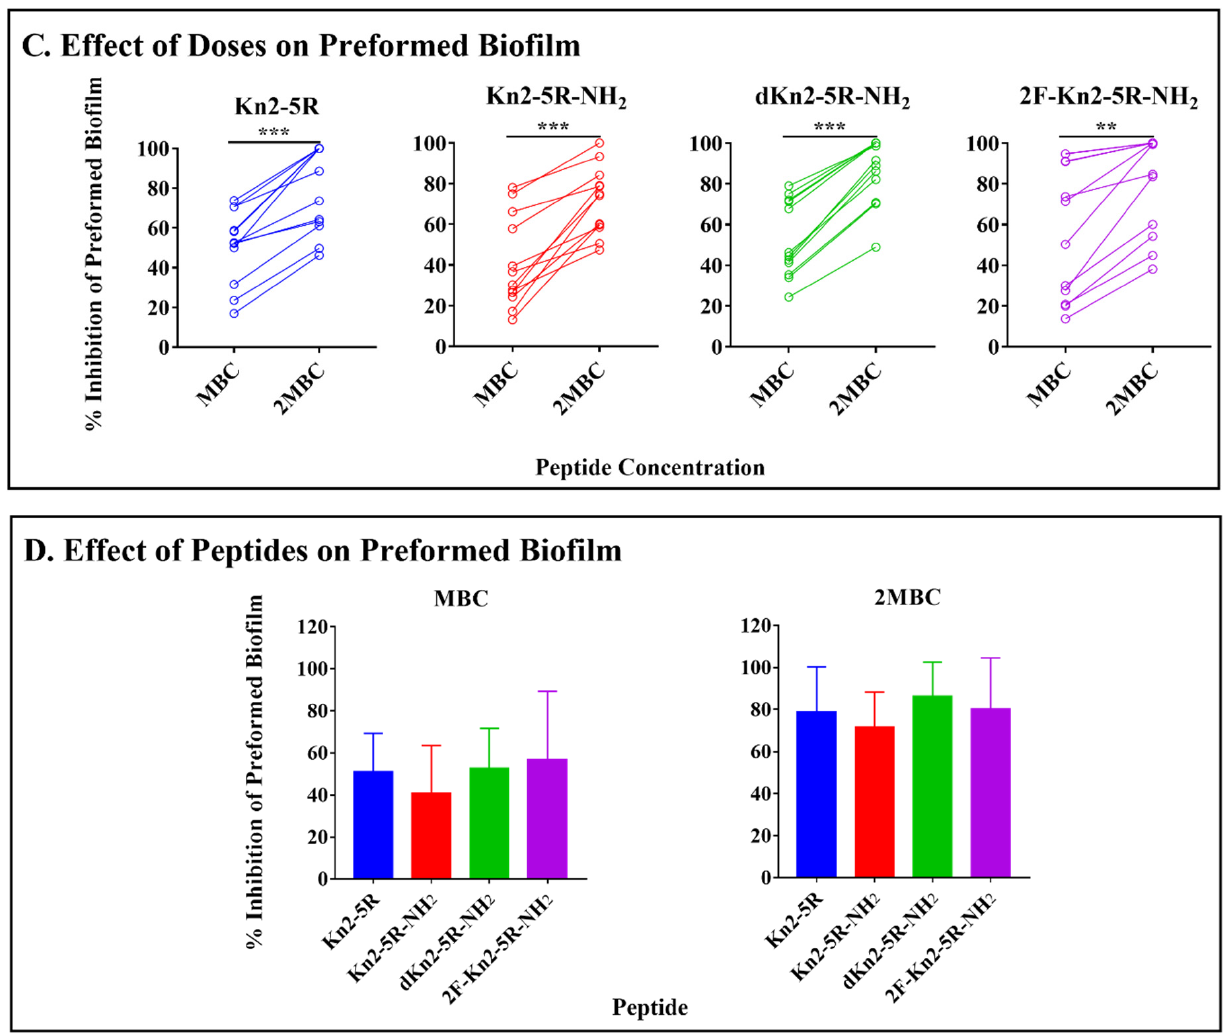
Figure 2. Antibiofilm activities of the modified variant peptides. Effects of peptides on biofilm biomasses of 12 clinical Salmonella isolates were measured by crystal violet assay. Inhibitions (%) of cell attachment treated with peptides at 0.25MBC and 0.5MBC; ( A ): effect of doses of each peptide on each isolate, ( B ): effect of each peptide at the same doses on all isolates. Inhibition (%) of 24-h preformed biofilm treated with peptides at MBC and 2MBC; ( C ): effect of doses of each peptide on each isolate, ( D ): effect of each peptide at the same doses on all strains. Paired t-test and repeated measures one-way ANOVA with Tukey’s multiple comparison test were used to compare two groups and more than two groups, respectively (* p -value < 0.05, ** p -value < 0.001, *** p -value < 0.0001).